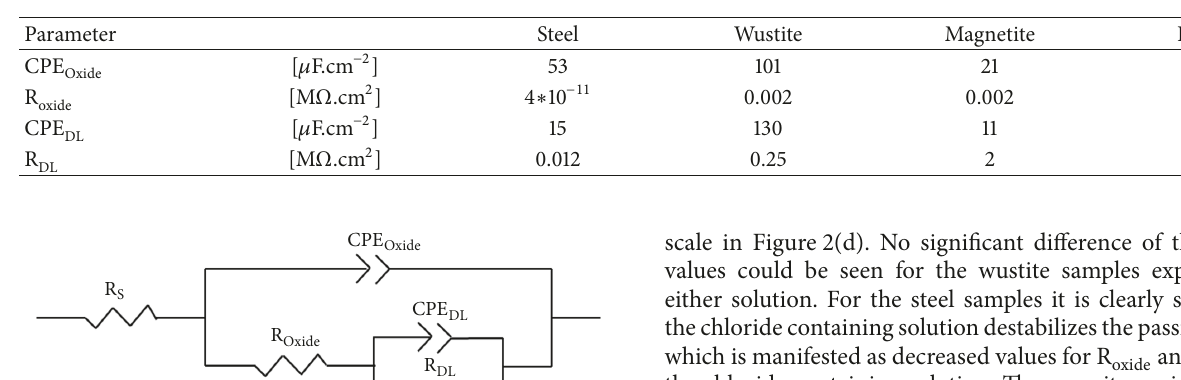
Table 7: Parameter data obtained from the equivalent circuit fitting for samples exposed in sat. Ca(OH) 2 with 0.6 M Cl − . The data values are an average of two samples.